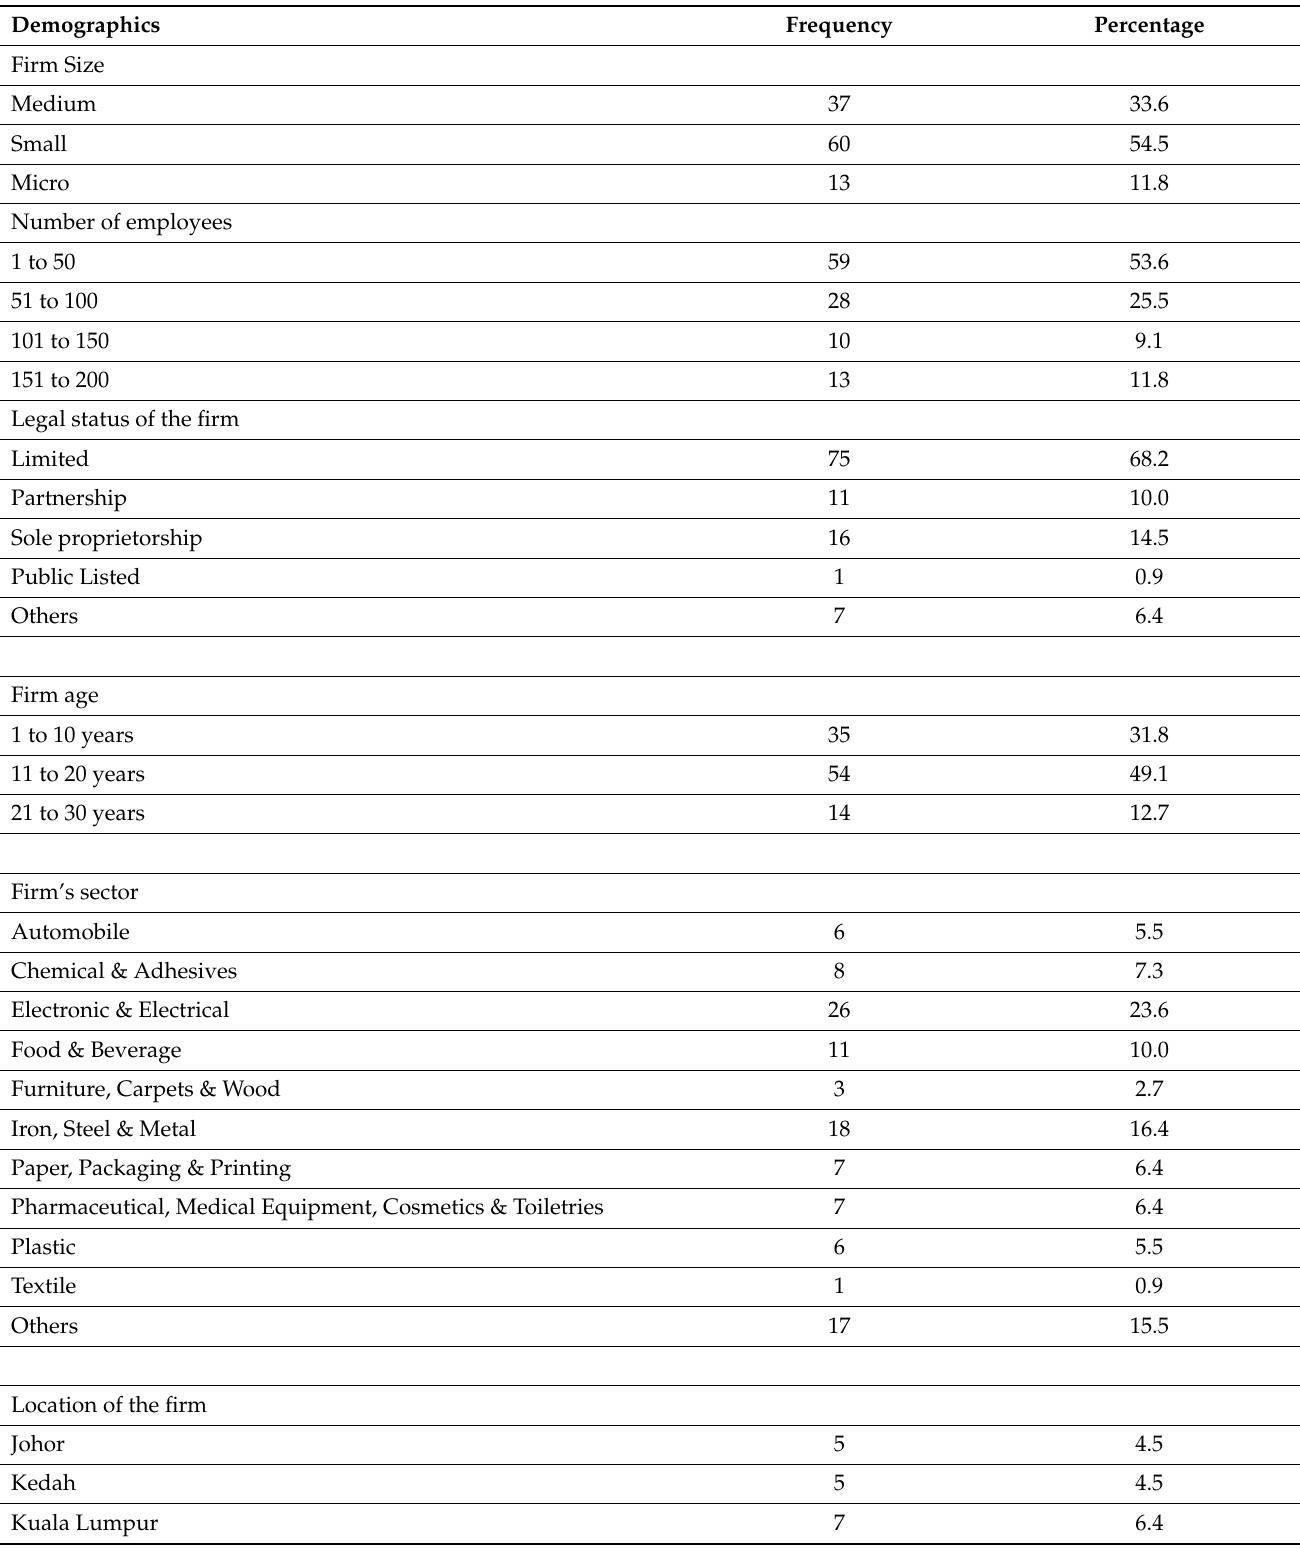
Table 7. Respondent’s background information and company